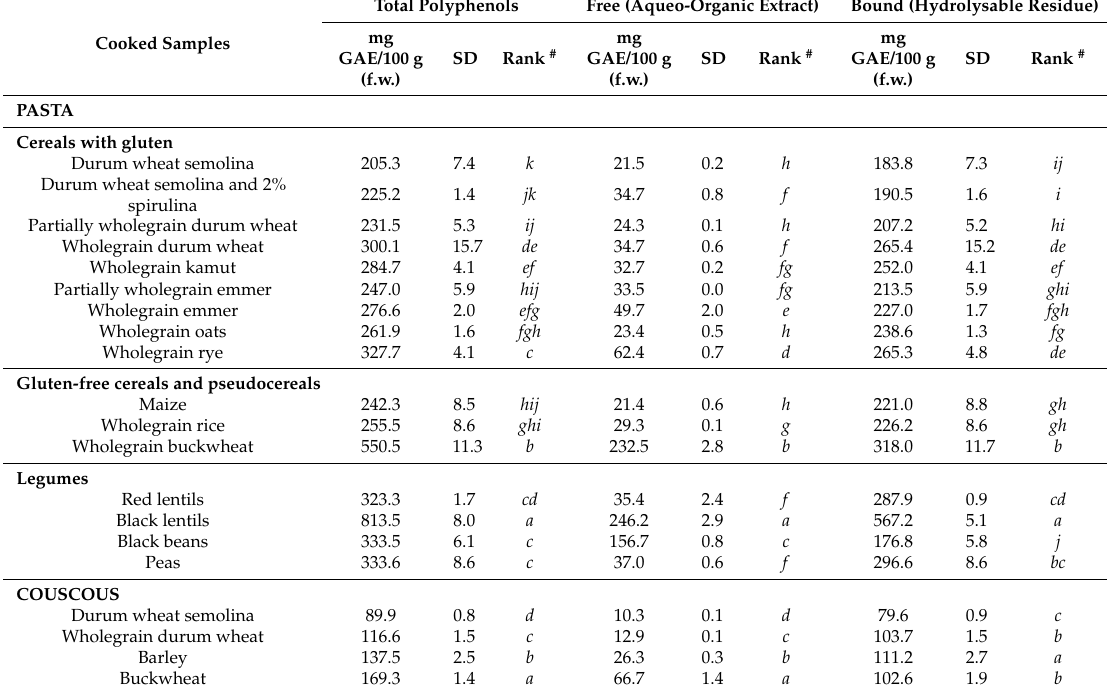
Table 3. Total polyphenol content, and free and hydrolysable bound fractions in cooked commercial samples of pasta and